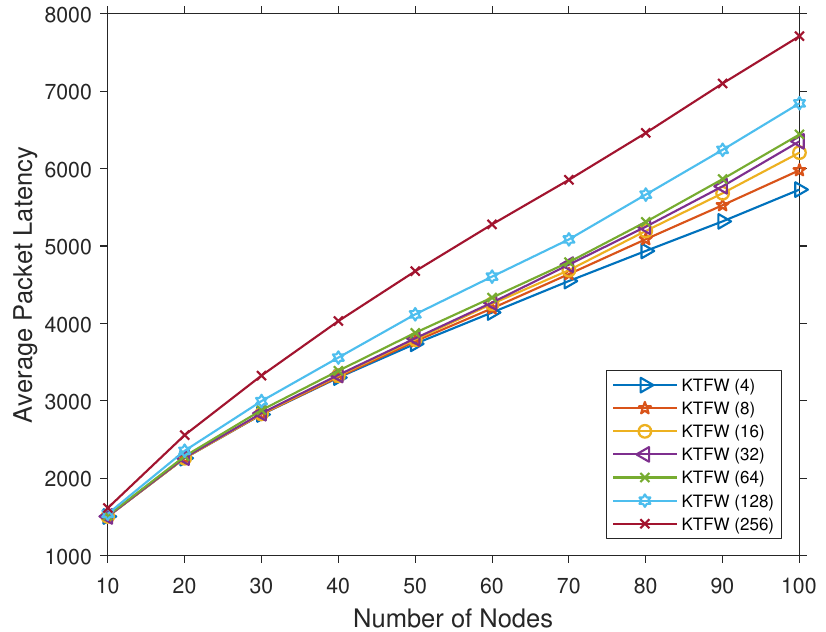
Figure 8. Comparing the average packet latency for different k values of the KTFW algorithm and all n ∈